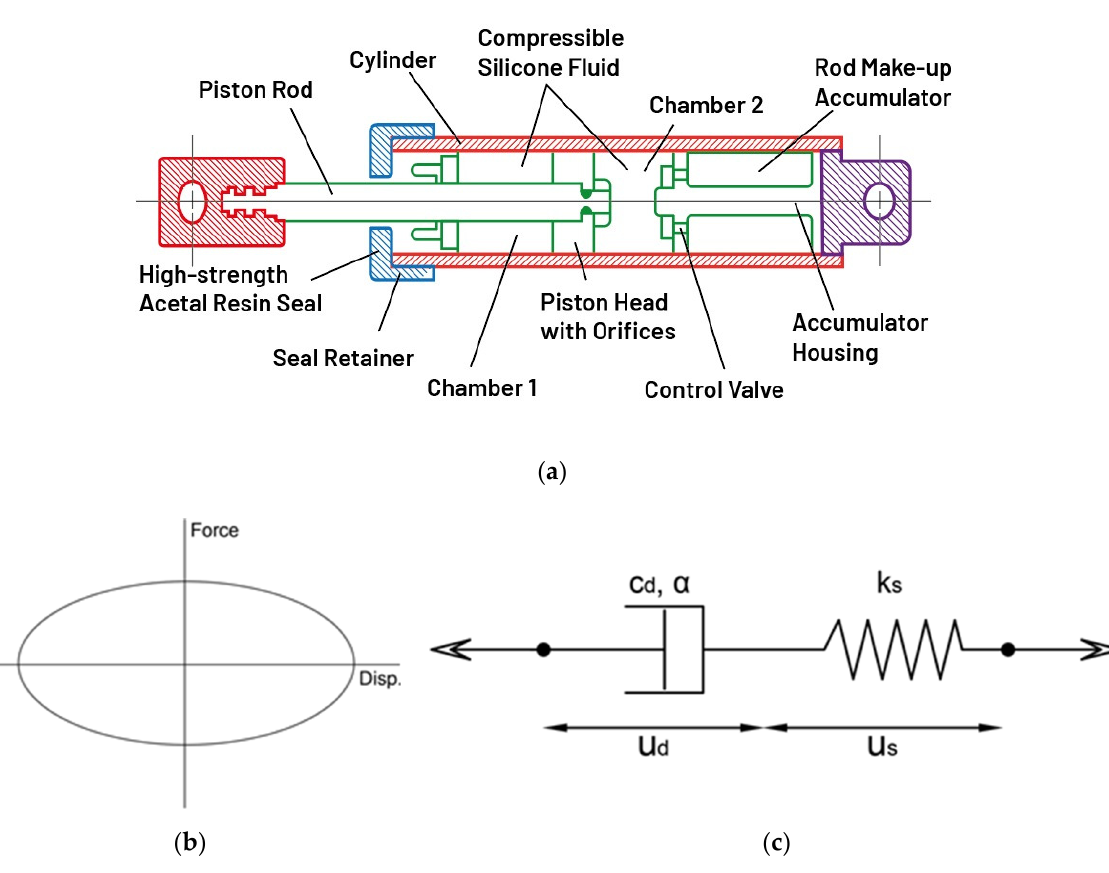
Figure 4. ( a ) Section view of viscous damper (VD), ( b ) idealized force–displacement relationship for VD, ( c ) schematic view of Maxwell model (Adapted with permission from [30]).